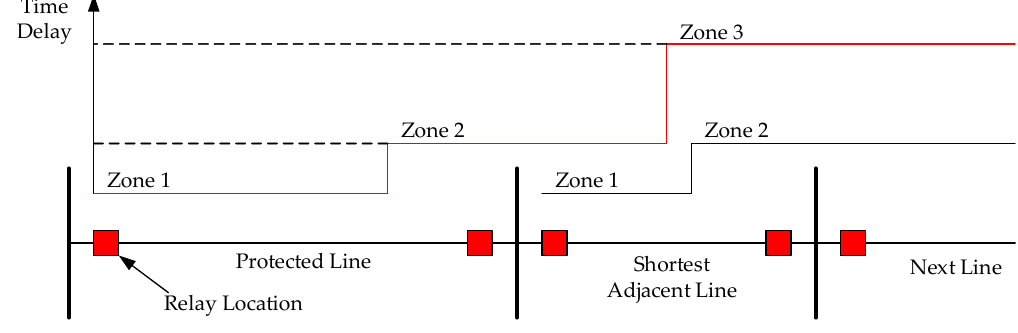
Figure 2. Typical zone reach coordination for distance protection.